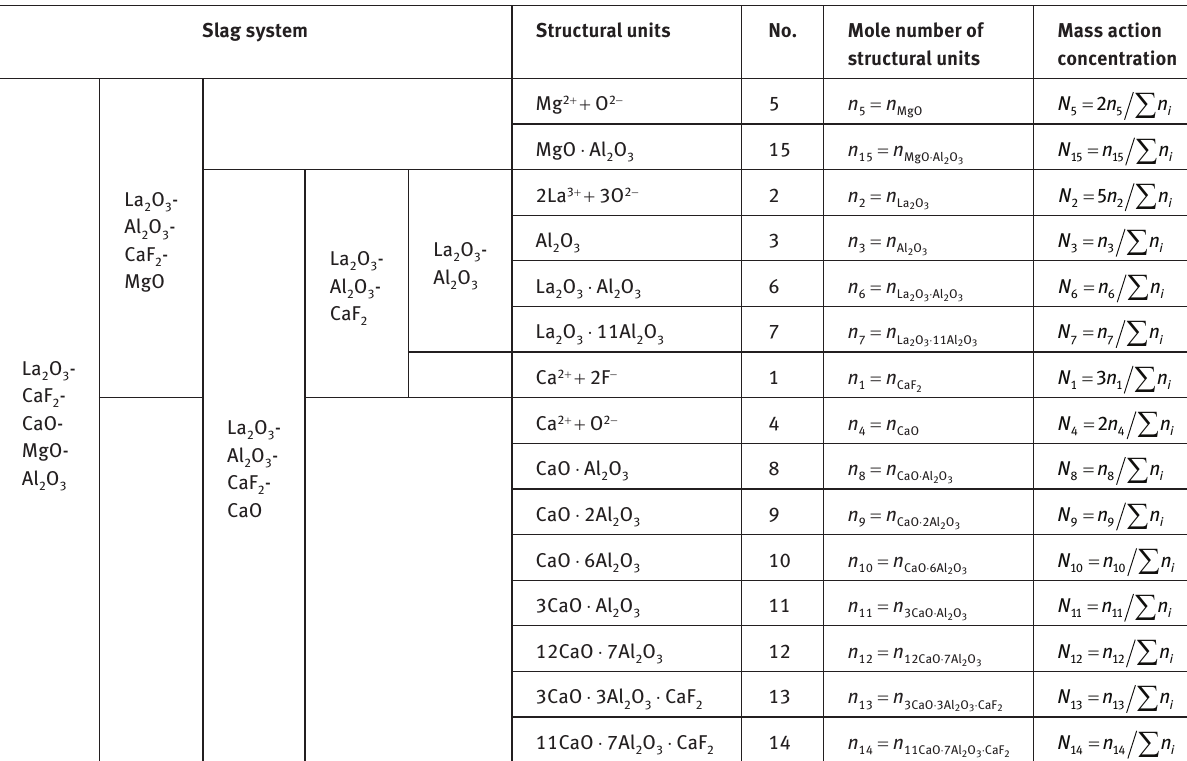
Table 1: Expression of structural units, their mole numbers and mass action concentrations of La 2 O 3 -Al 2 O 3 , La 2 O 3 -Al 2 O 3 -CaF 2 , La 2 O 3 -Al 2 O 3 - CaF 2 -CaO, La 2 O 3 -Al 2 O 3 -CaF 2 -MgO and La 2 O 3 -Al 2 O 3 -CaF 2 -CaO-MgO slags at metallurgical temperature based on the ion and molecule coexistence